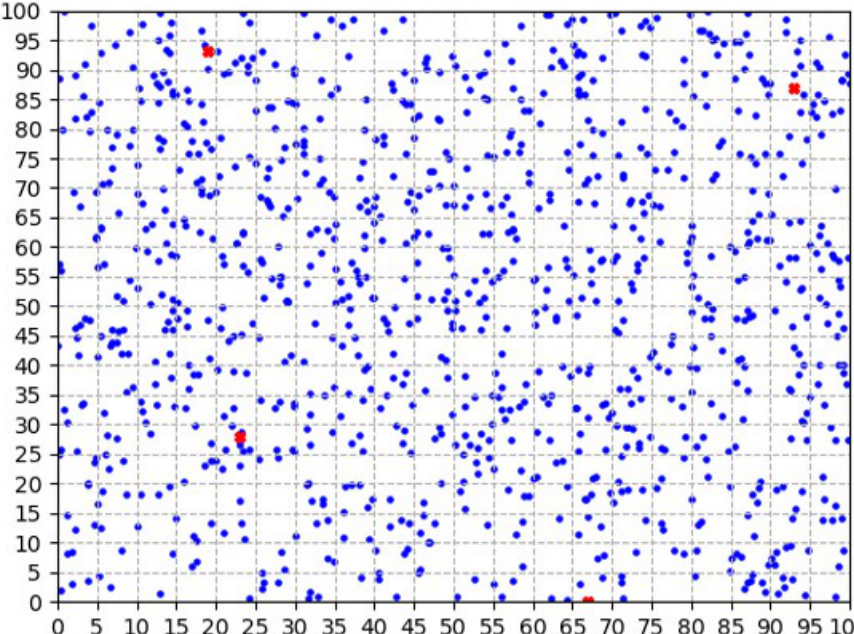
Figure 2. Distribution of sensor